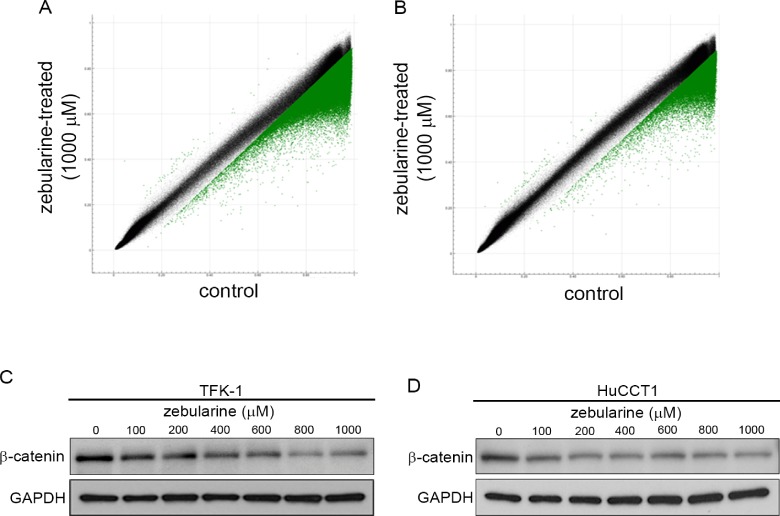
Effect of zebularine on DNA methylation and β-catenin expression in CCA cell lines.Scatter plot of the average beta values at 482,143 CpG sites for zebularine-treated (y-axis) and control (x-axis) TFK-1 (A) and HuCCT1 (B) cells (n = 3 for each group). Dots for CpG sites whose delta-beta value is >0.1 or <-0.1 are shown in green (59 [0.012%] hypermethylated and 151,482 [31.4%] hypomethylated CpG sites in TFK-1 cells and 70 [0.015%] hypermethylated and 47,438 [9.8%] hypomethylated CpG sites in HuCCT1 cells). The protein levels of β-catenin in TFK-1 (C) and HuCCT1 (D) cells after zebularine treatment for 72 h at different concentrations. After treatment, the cells were harvested and western blot analysis was performed to detect the protein levels of β-catenin. GAPDH was used as a loading control.